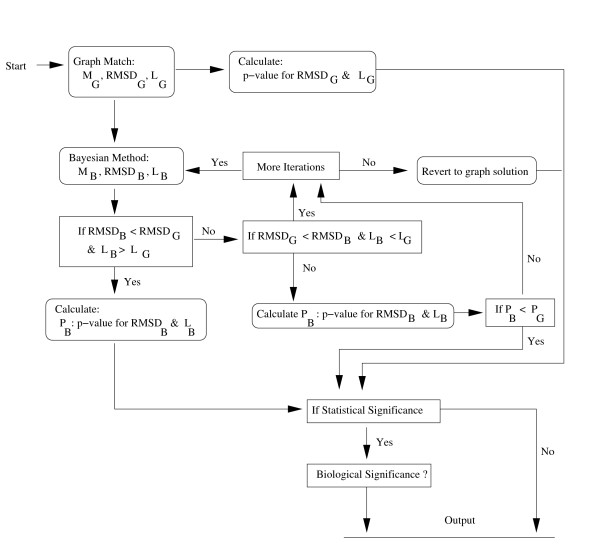
Decision tree for refining the graph solution by the MCMC method. Boxes with curved corners show processes and their output while boxes with sharp corners are for branching conditions. The procedure starts with graph solution MG. The graph solution's RMSD and number of matches are denoted by RMSDG and LG respectively. MCMC is re-iterated until the MCMC solution: MB is better. The RMSD and number of matches for MB are denoted by RMSDB and LB respectively. MB and MG are compared using 1) RMSDs and the number of matches or 2) P-values for MG and MG, denoted by PG and PB respectively.